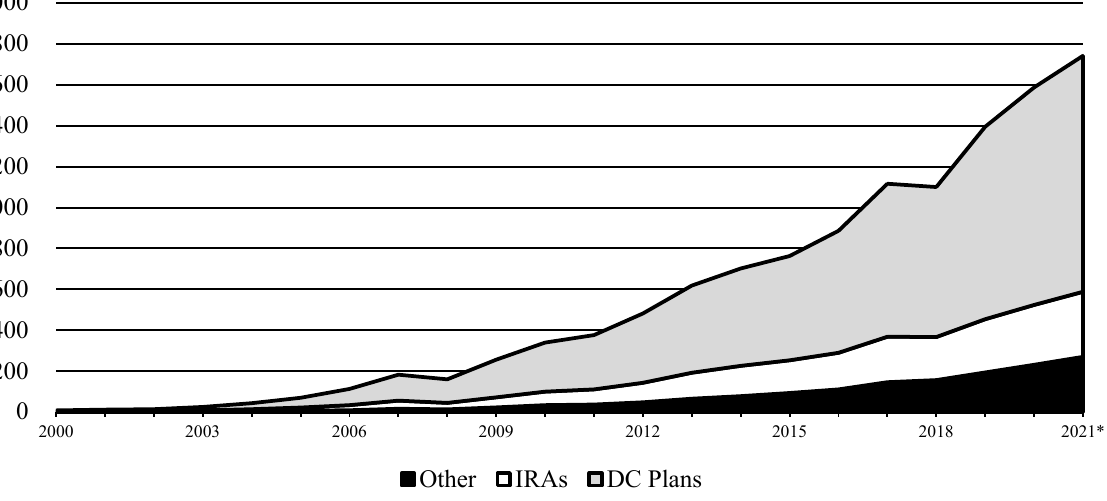
Figure 2. Target Date Fund Investing ($USD billion). Source: Investment Company Institute (https://www.ici.org/research/stats/retirement accessed on 25 August 2021). * Data for 2021 is as of the end of the third quarter.